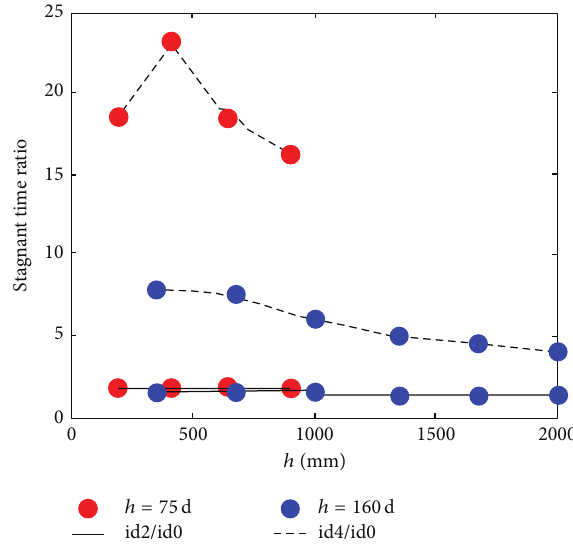
Figure 10: Experiment results of stagnant time ratio id2/id0, id4/id0, of the experiment installation with ℎ = 75 d and ℎ = 160